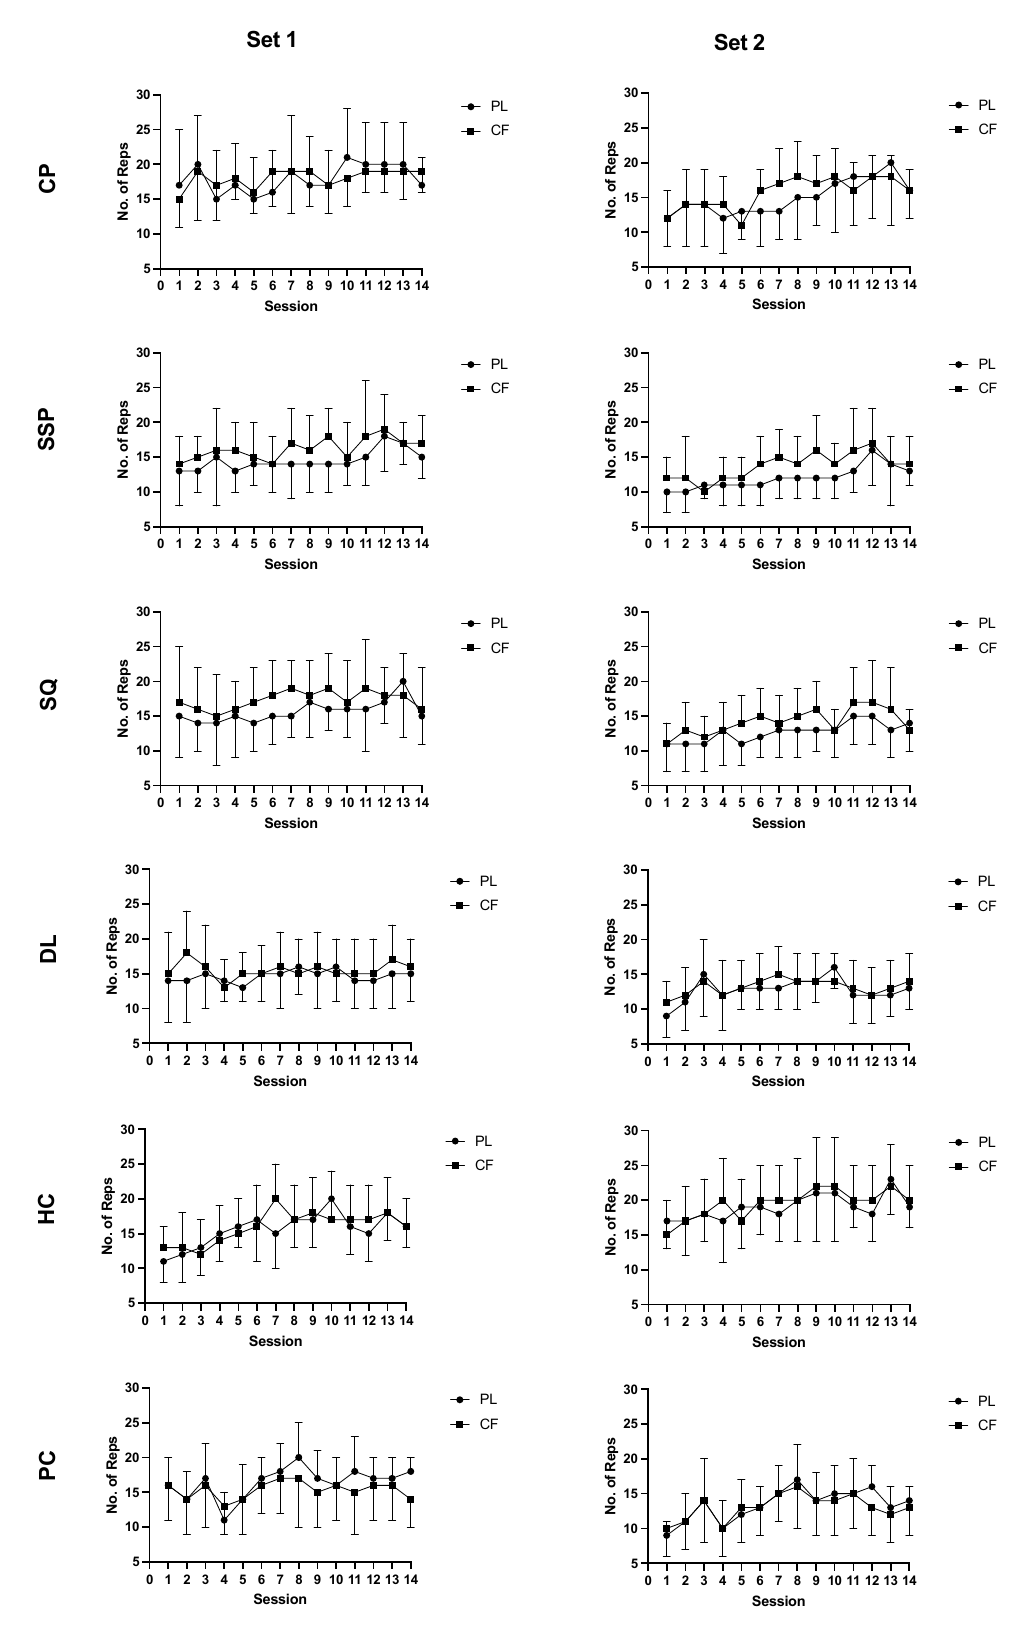
Figure 5 - Effect of caffeine treatment (3 mg . kg − 1 ) during the 7-week resistance training program on sessional RTF. Figure 5. Effect of caffeine treatment (3 mg · kg − 1 ) during the 7-week resistance training program on sessional